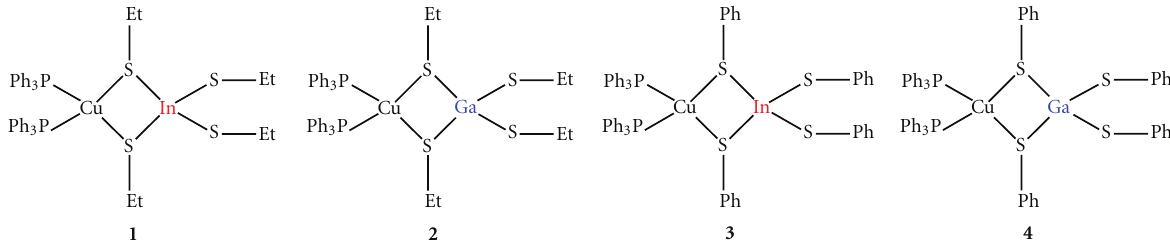
Figure 1: Single-source precursors 1 through 4